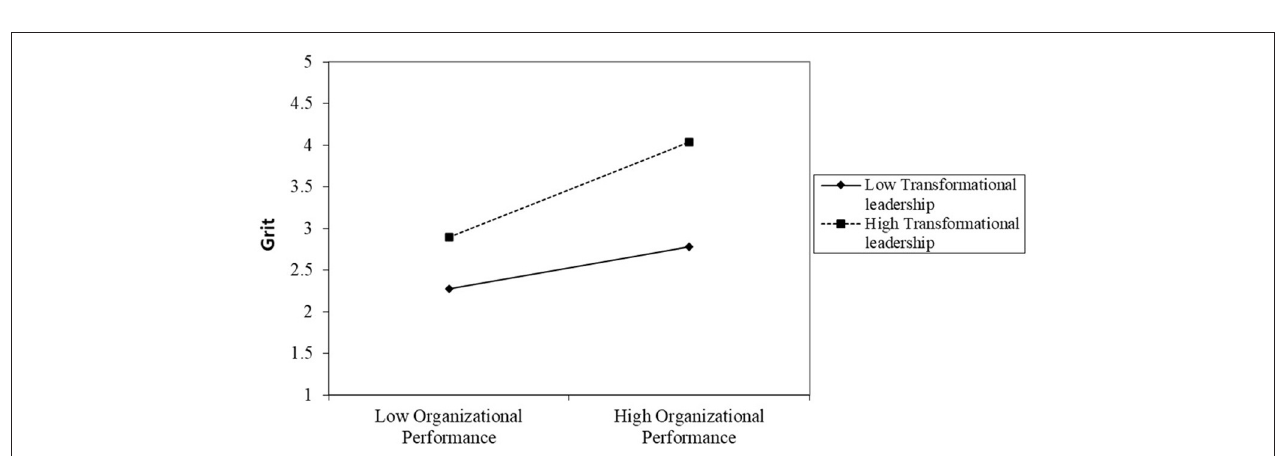
FIGURE 3 | Moderating effect of supportive climate on the relationship between grit and organizational performance.